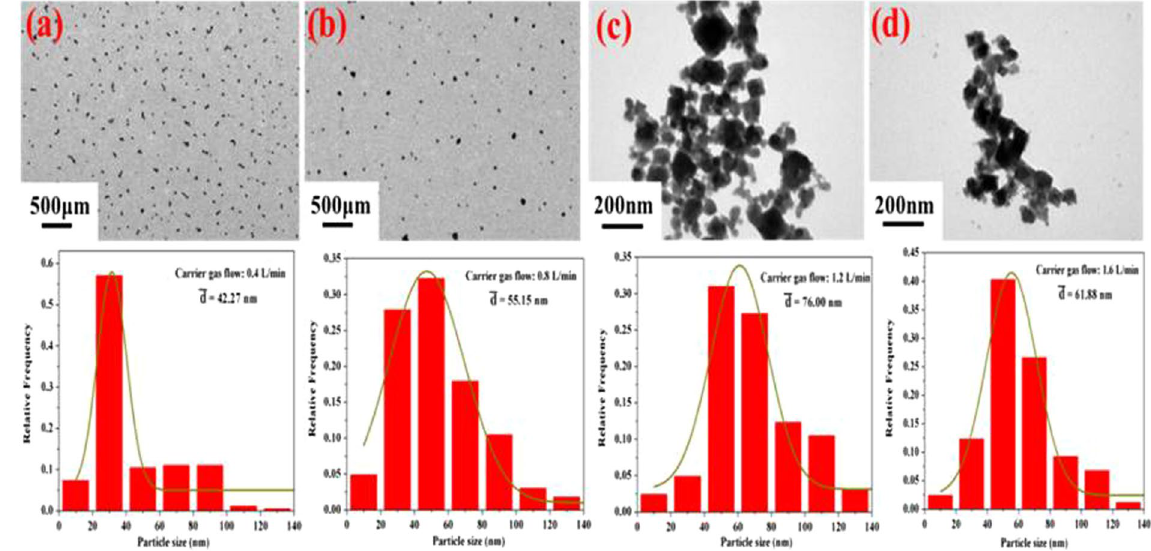
Figure 7. Morphologies and size distribution of the synthesized GeAs ultrafine particles with different nitrogen gas flow rate ( a ) 0.4 L/min; ( b ) 0.8 L/min; ( c ) 1.2 L/min; ( d ) 1.6 L/min.